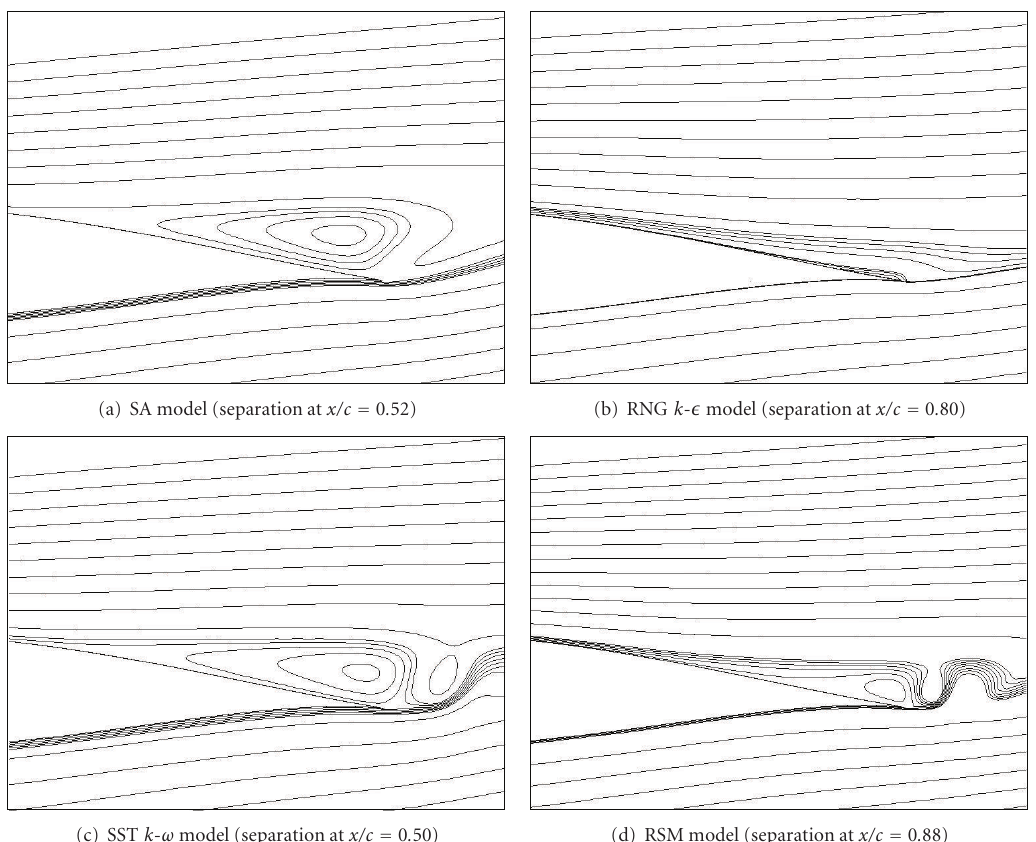
Figure 5: Streamlines after the application of various turbulence models at 16 ◦